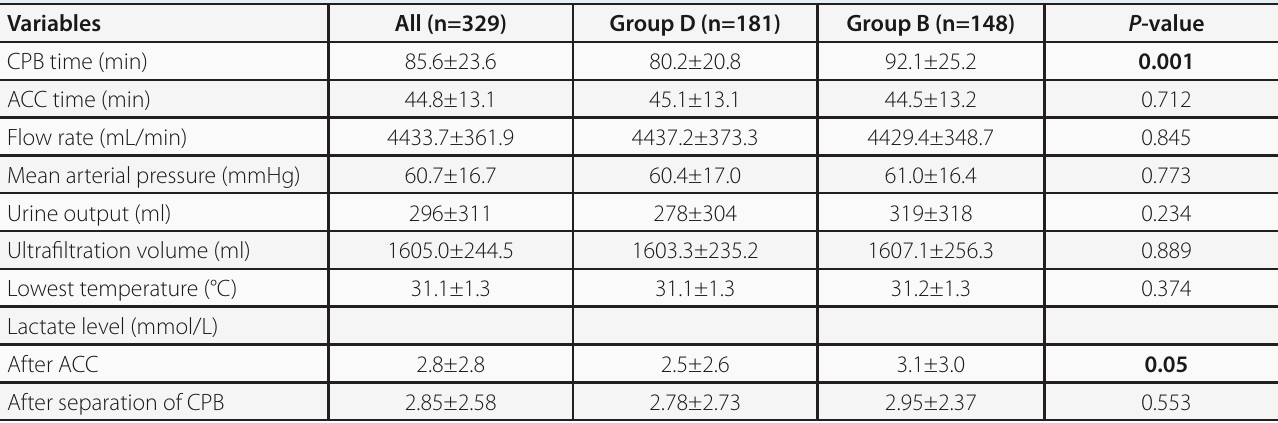
Table 2. Operative